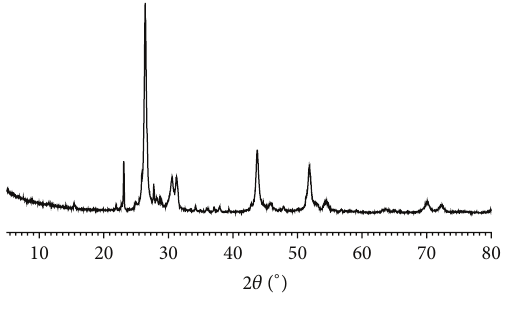
Figure 5: XRD fingerprint of Zuotai (average). Figure 6: XRD fingerprint of Zuotai